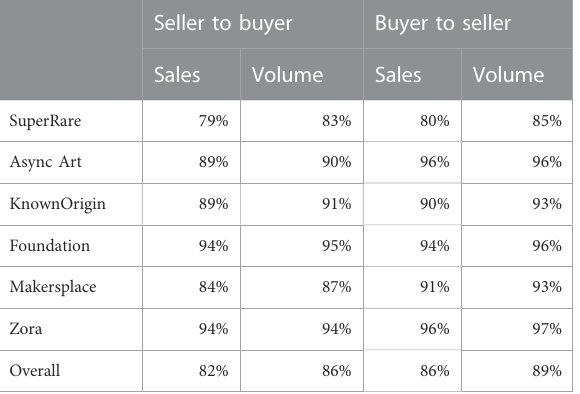
TABLE3Averagepreferentialtiescores:thefractionofsalesandvolume(in USD) from aseller to their preferential buyer (columns 1and2), andfrom a buyer to their preferential seller (columns 3 and 4). Seller to buyer Buyer to